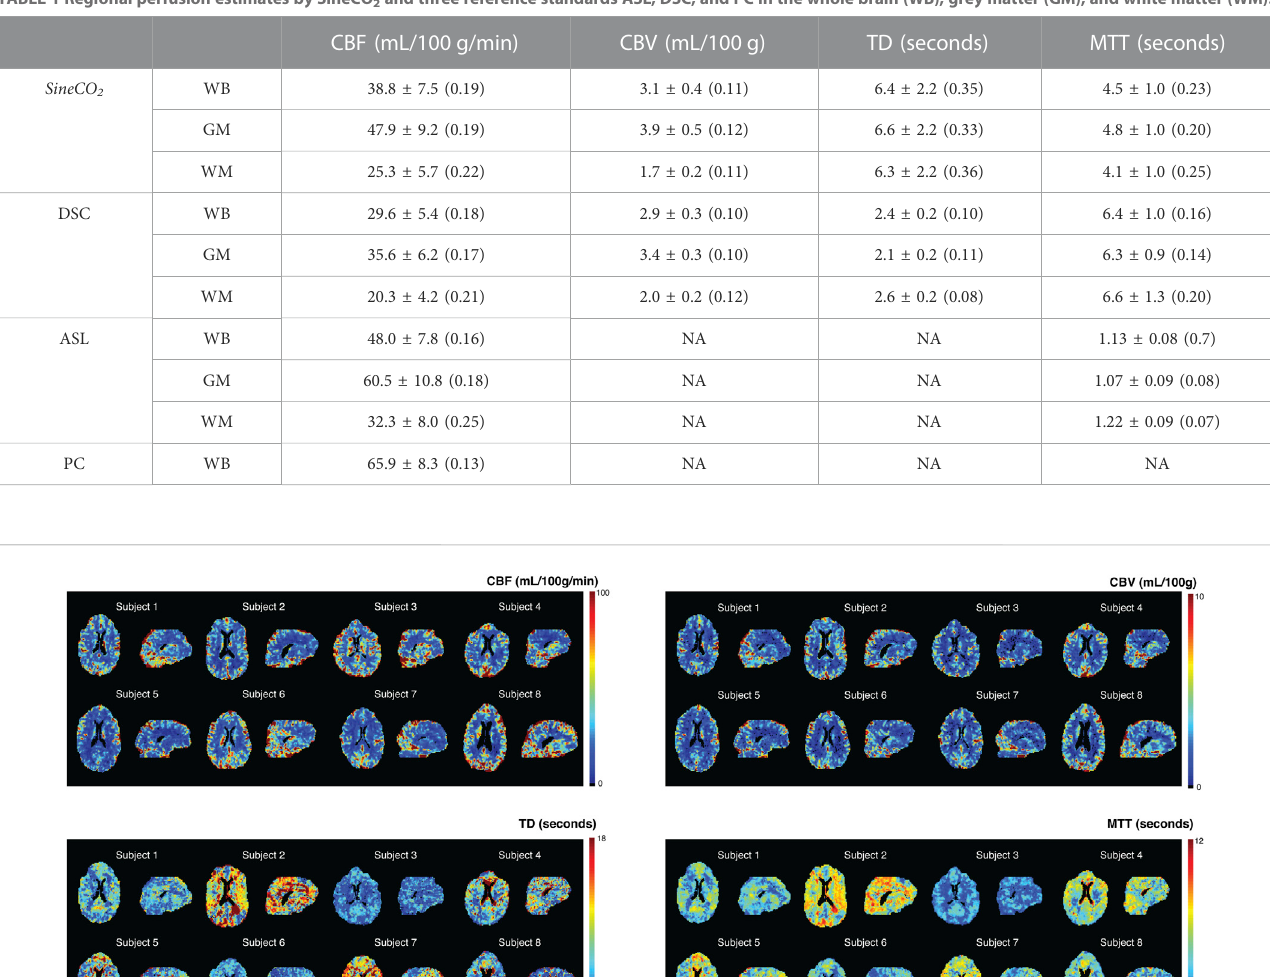
TABLE 1 Regional perfusion estimates by SineCO 2 and three reference standards ASL, DSC, and PC in the whole brain (WB), grey matter (GM), and white matter (WM).